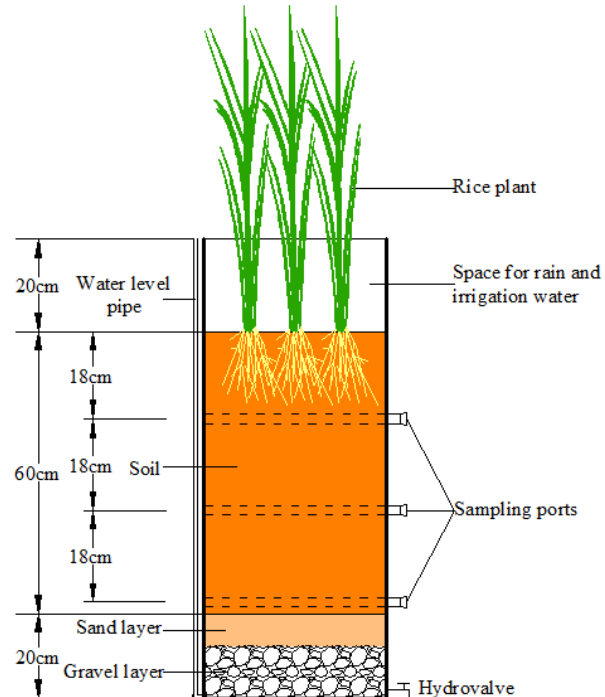
Figure 1. Sketch of the designed experimental bucket.